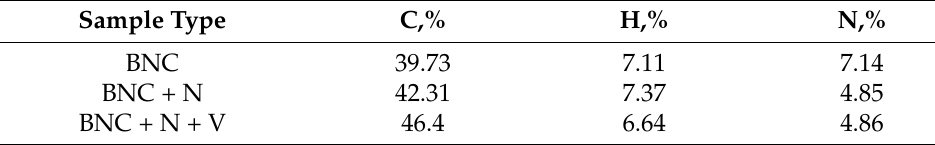
Table 2. Results of elemental analysis of BNC, BNC + N, BNC + N + V